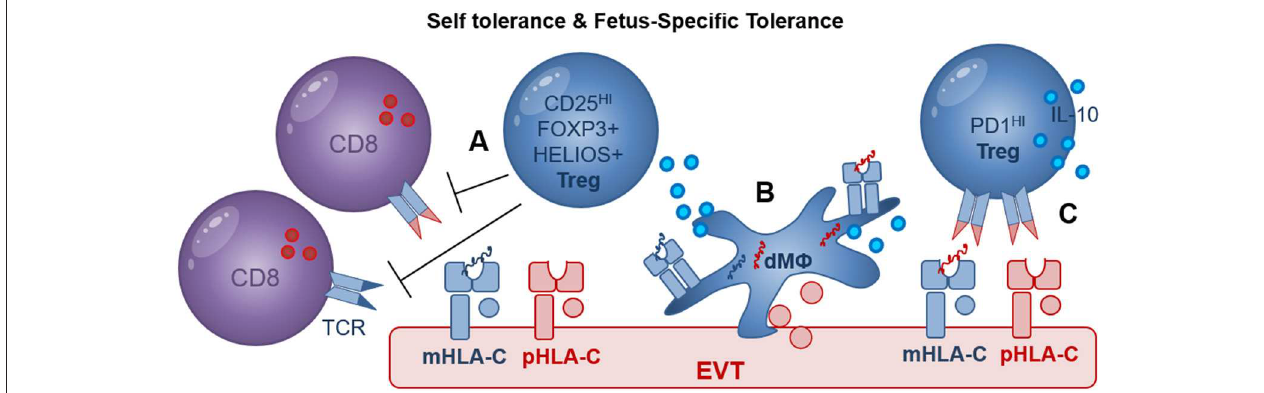
FIGURE 4 | Treg mediated recognition of HLA-C may include self- and fetus-specific tolerance. (A) CD25 HI FOXP3 + Treg were shown to suppress fetus-specific and non-specific lymphocyte responses; maternal HLA-C (mHLA-C, blue), paternal HLA-C (pHLA-C, red); (B) Decidual macrophages (dM 8 ) and EVT directly increase the proportion of FOXP3 + Treg during in vitro co-culture assays; maternal peptides (blue), paternal peptides (red); (C) EVT directly increase the proportion of PD1 HI Treg in a process where HLA-C and TCR interaction may play a role. In addition, efficient induction of FOXP3 + Treg and PD1 HI Treg by dM 8 and EVT may depend on cell surface receptors as well as secreted cytokines including